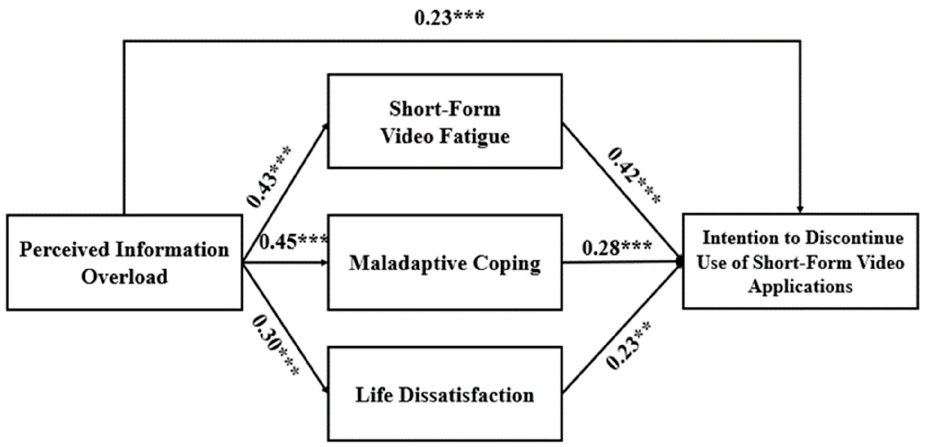
effects. Figure 2 indicates the standardized coefficients and significance values for each path in the hypothesized model.